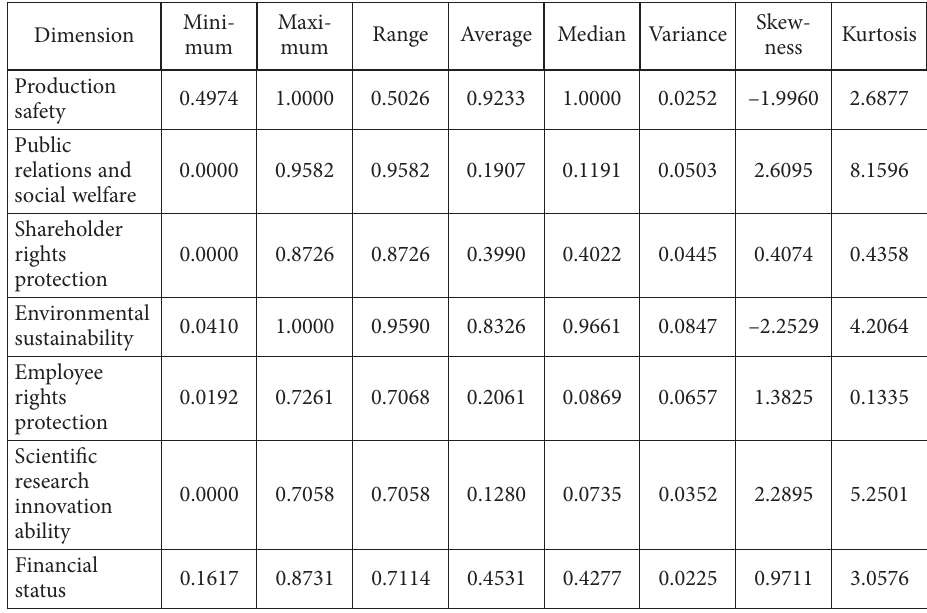
Table 4. Distribution of evaluation scores by